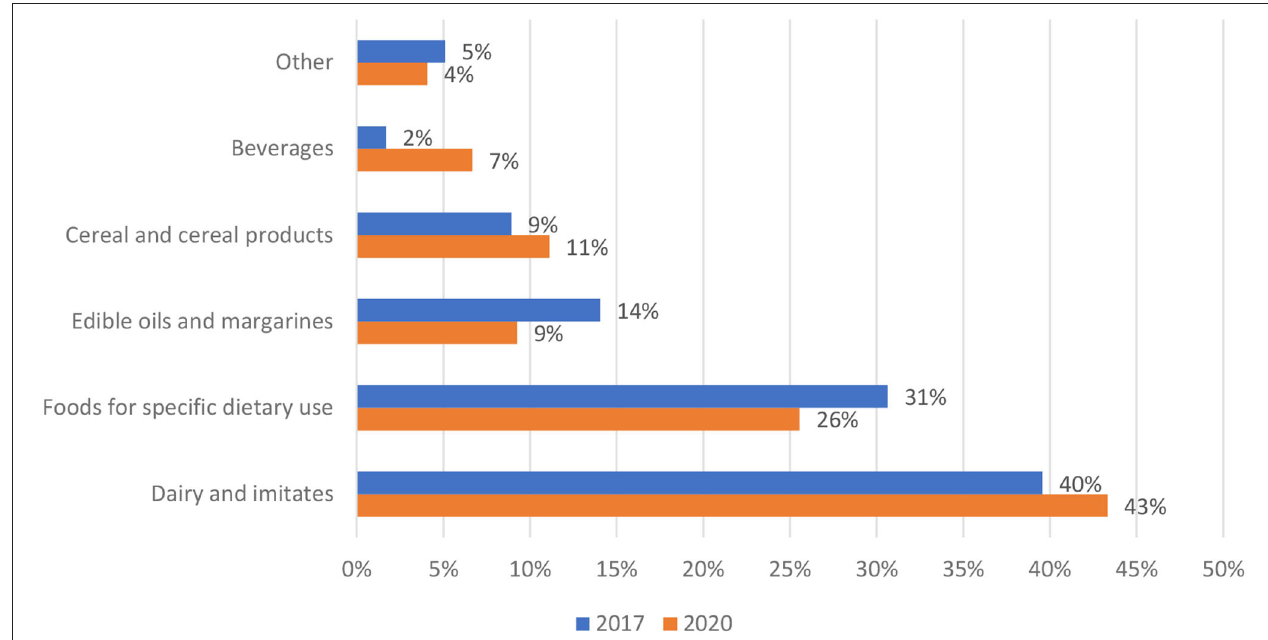
FIGURE 1 | Distribution of prepacked foods fortified with vitamin D per food (sub)categories in years 2017 ( N = 235) and 2020 ( N = 270)